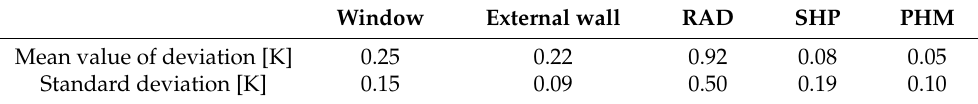
Table A1. Deviations of the surface temperatures between simulation and measured values.